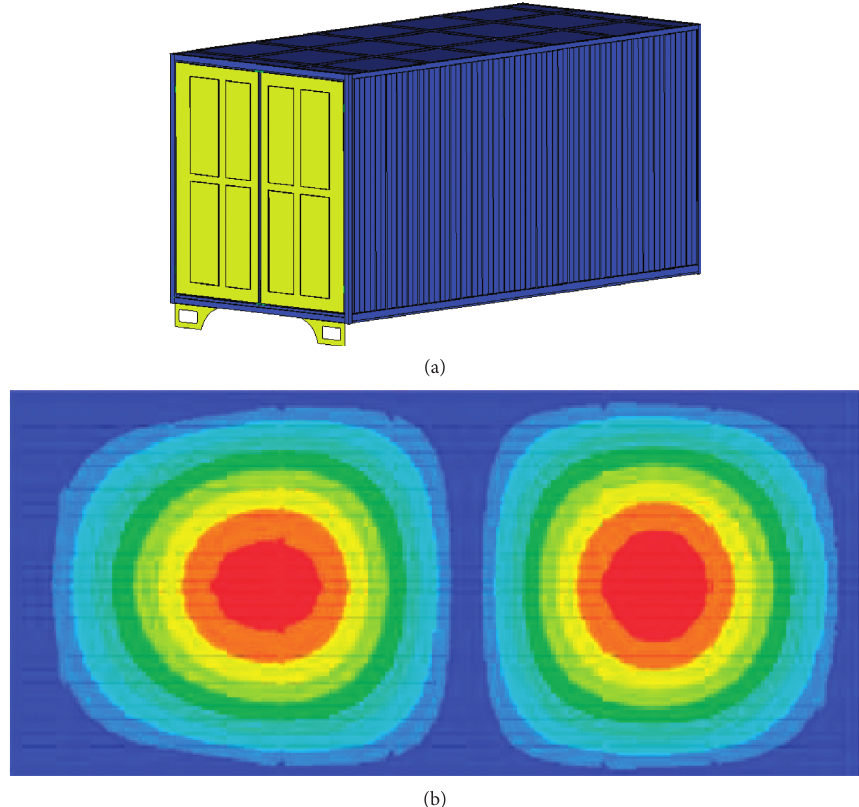
Figure 9: Modal analysis of the carriage: (a) the finite element model and (b) the mode shape below 30